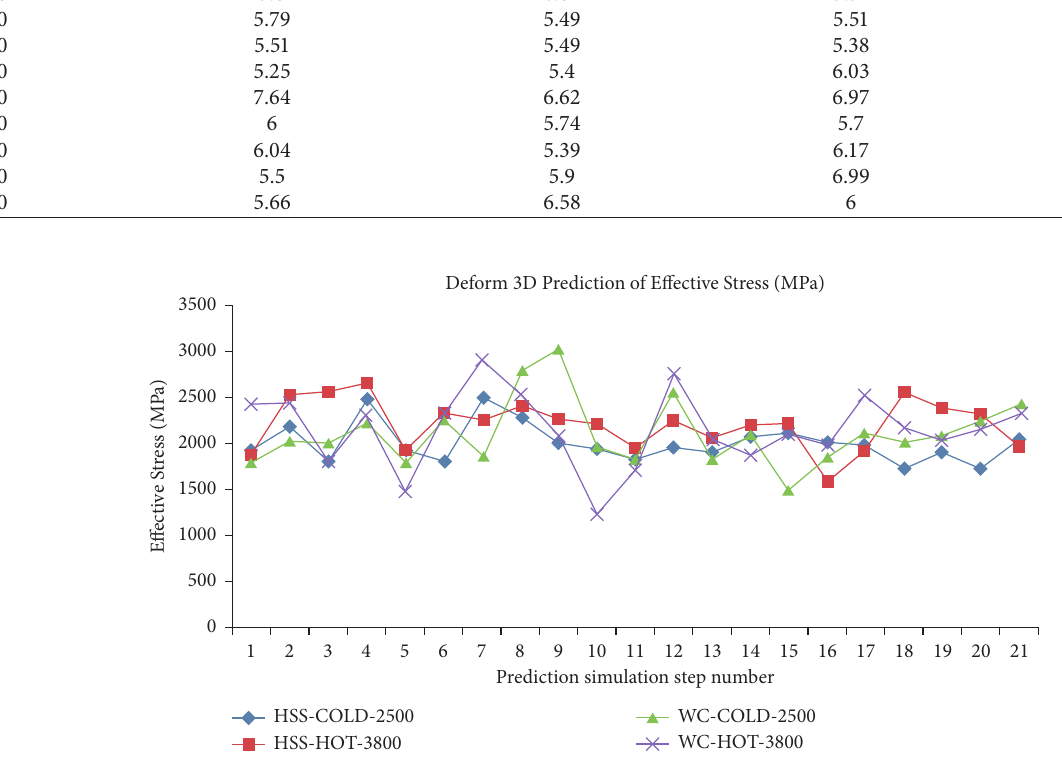
Figure 8: Predicted results of effective stress (MPa) for different step number of Deform 3D.